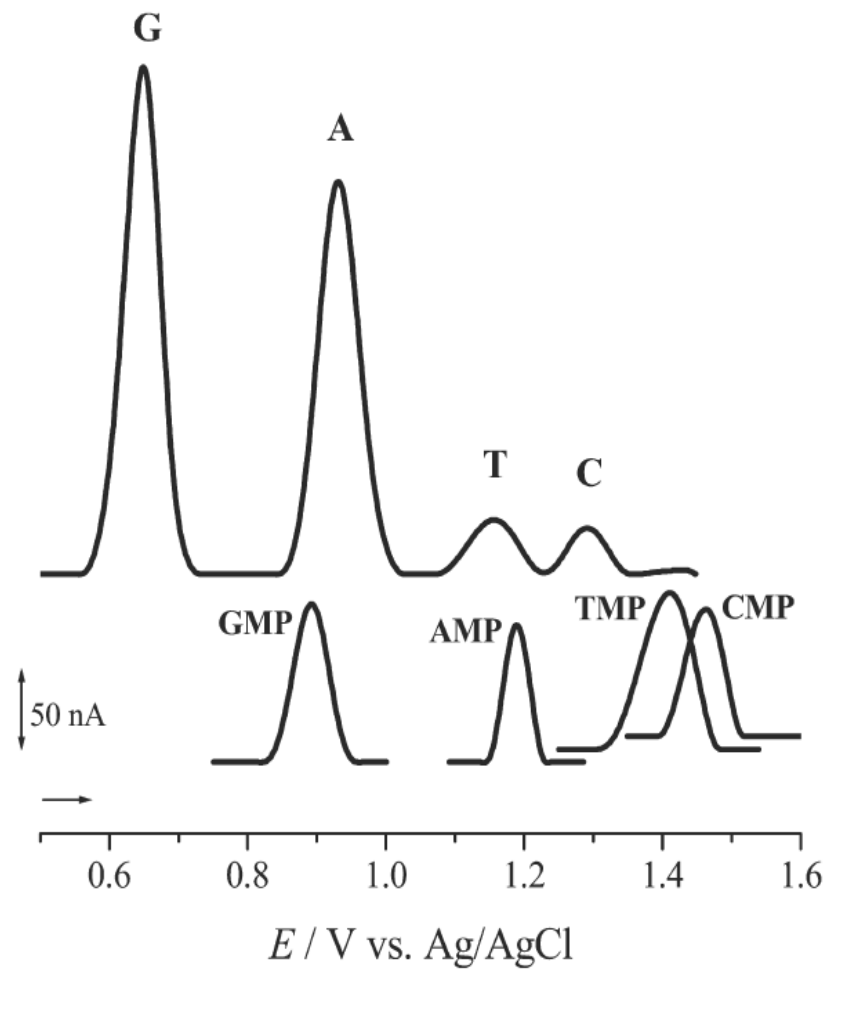
Figure 2. Baseline-corrected differential pulse voltammograms obtained for a 20 µ M equimolar mixture of guanine (G), adenine (A), thymine (T), and cytosine (C), 20 µ M guanosine 5- monophosphate (GMP), 20 µ M adenosine 5-monophosphate (AMP), 500 µ M thymidine 5- monophosphate (TMP), and 500 µ M cytidine 5-monophosphate (CMP) in pH 7.4, 0.1 M phosphate buffer supporting electrolyte. Pulse amplitude 50 mV; pulse width 70 ms; scan rate 5 mVs -1 . [From Ref [12] with